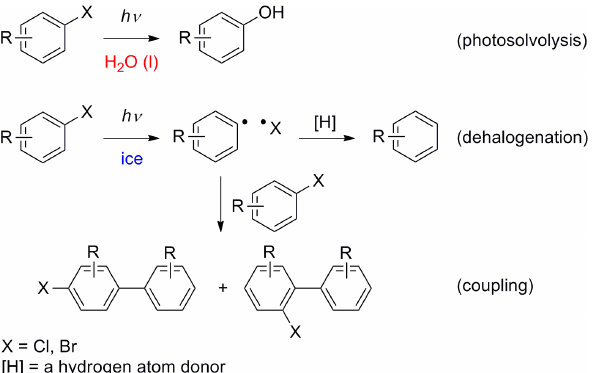
Fig. 9. Comparison of photochemistry of haloarenes in water and frozen aqueous solutions, illustrating the different mechanisms and products that occur in liquid water and